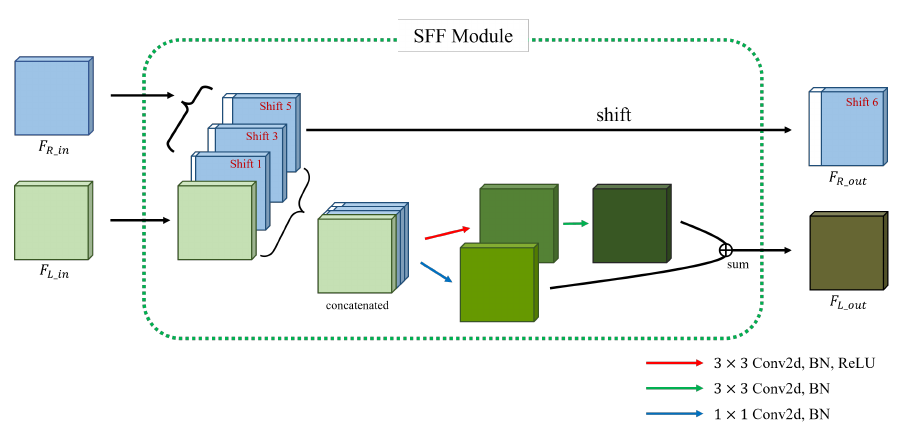
Figure 4. Details of a single SFF module in the S 1 .